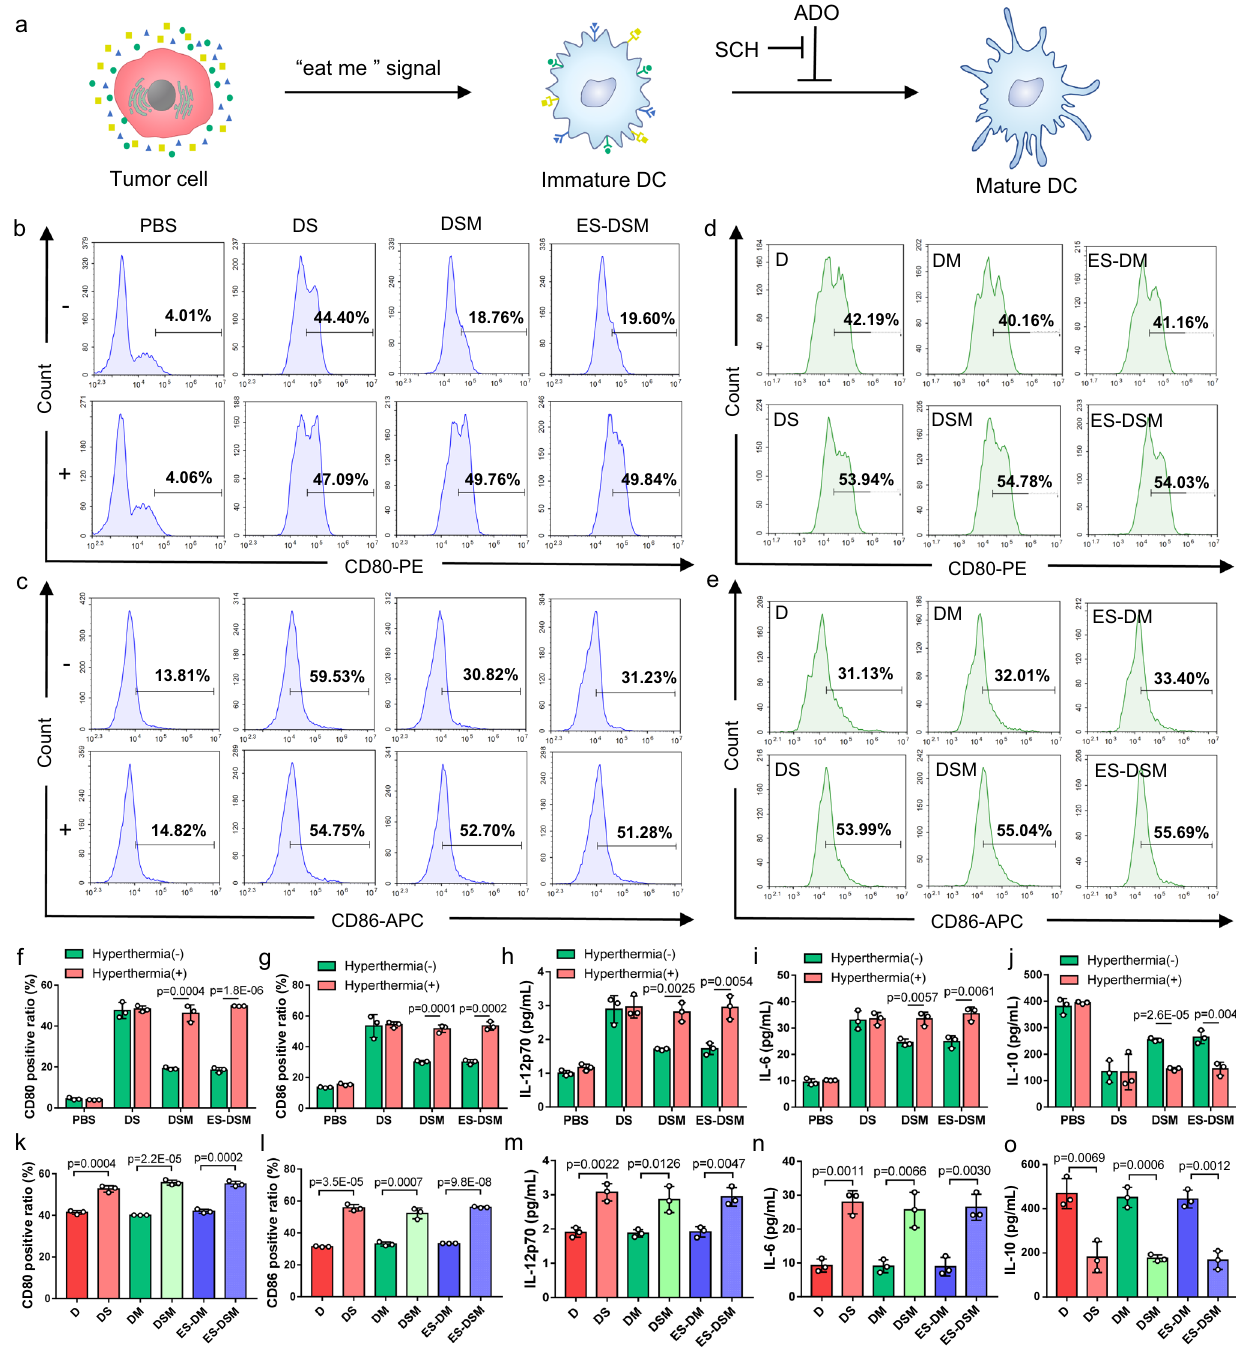
Fig. 4 Analysis of DCs after co-incubating with pretreated tumor cells. a Schematic of DC maturation facilitated by tumor ICD. ADO can inhibit this process by binding to A2AR on DCs, and SCH can block this interaction and relieve immunosuppression. Flow cytometry analysis of the expression of b CD80 and c CD86 on DCs after co-incubation with pretreated tumor cells, as well as d CD80 and e CD86 on DCs after co-incubation with pretreated tumor cells in the presence of NECA. Ratios of f CD80 and g CD86 positive DCs calculated based on ( b ) and ( c ), respectively ( n = 3 independent experiments). h IL-12p70, i IL-6, and j IL-10 secreted by DCs in the co-incubation system after different treatments were detected by ELISA kits ( n = 3 independent experiments). Ratios of k CD80 and l CD86 positive DCs calculated based on ( d ) and ( e ), respectively ( n = 3 independent experiments). m IL-12p70, n IL-6, and o IL-10 secreted by DCs in the NECA- containing co-incubation system after different treatments were detected by ELISA kits ( n = 3 independent experiments). ADO: adenosine; A2AR: A2A adenosine receptor; NECA: an analog of adenosine; DS: free DOX and SCH; DSM: DOX and SCH co-loaded micelles; ES-DSM: E-selectin-modi fi ed co-loaded micelles; D: free DOX; DM: DOX-loaded micelles; ES-DM: E-selectin-modi fi ed DOX-loaded micelles. Data are presented as mean values±SEM, and the mean value is the average of three independent experiments. Unpaired two-tailed T test was performed in ( f – o ). Source data are provided as a Source data fi